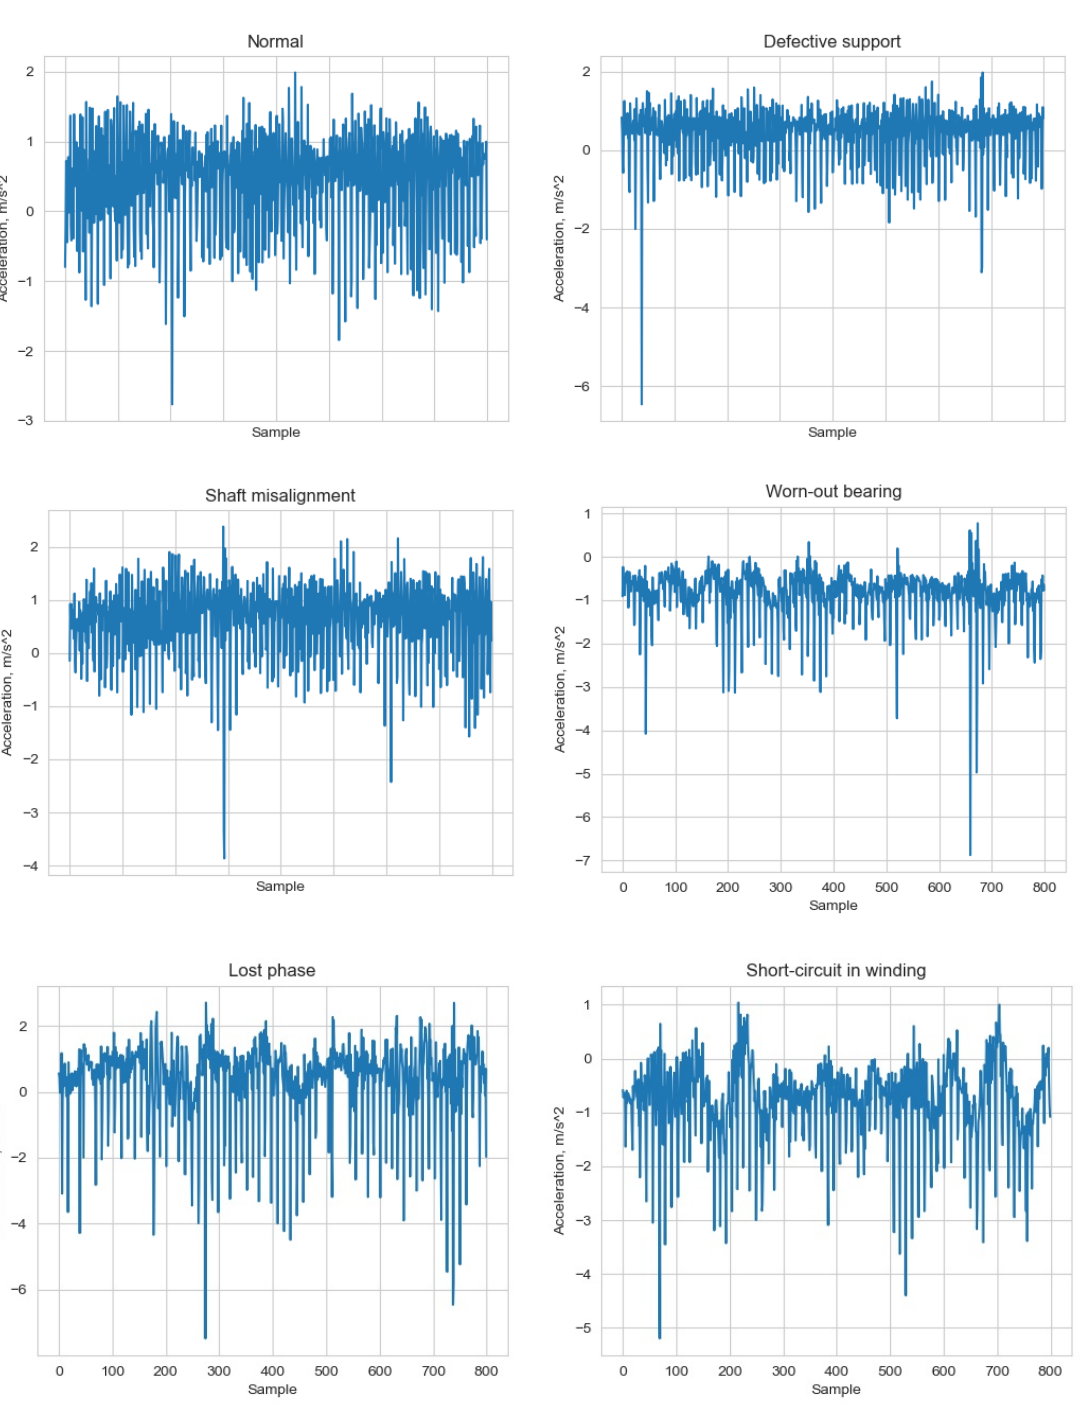
Figure 5. One sample of resulting dataset with all six classes.